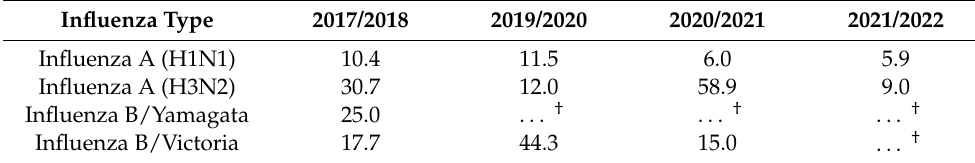
Table 6. Geometric mean titers of antibodies to vaccine strains in different